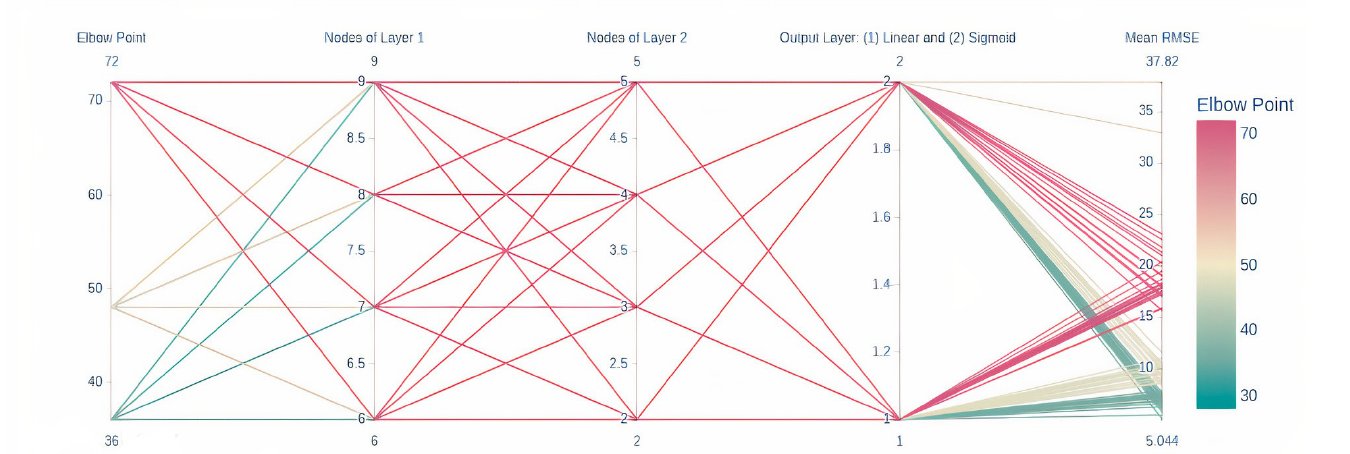
Figure 6. Hyperparameter Tuning of the RUL